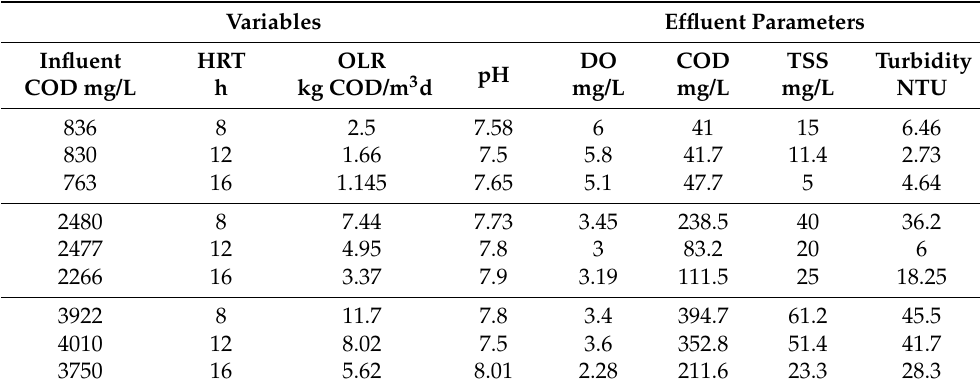
Table 4. SS-FFBR effluent quality under various